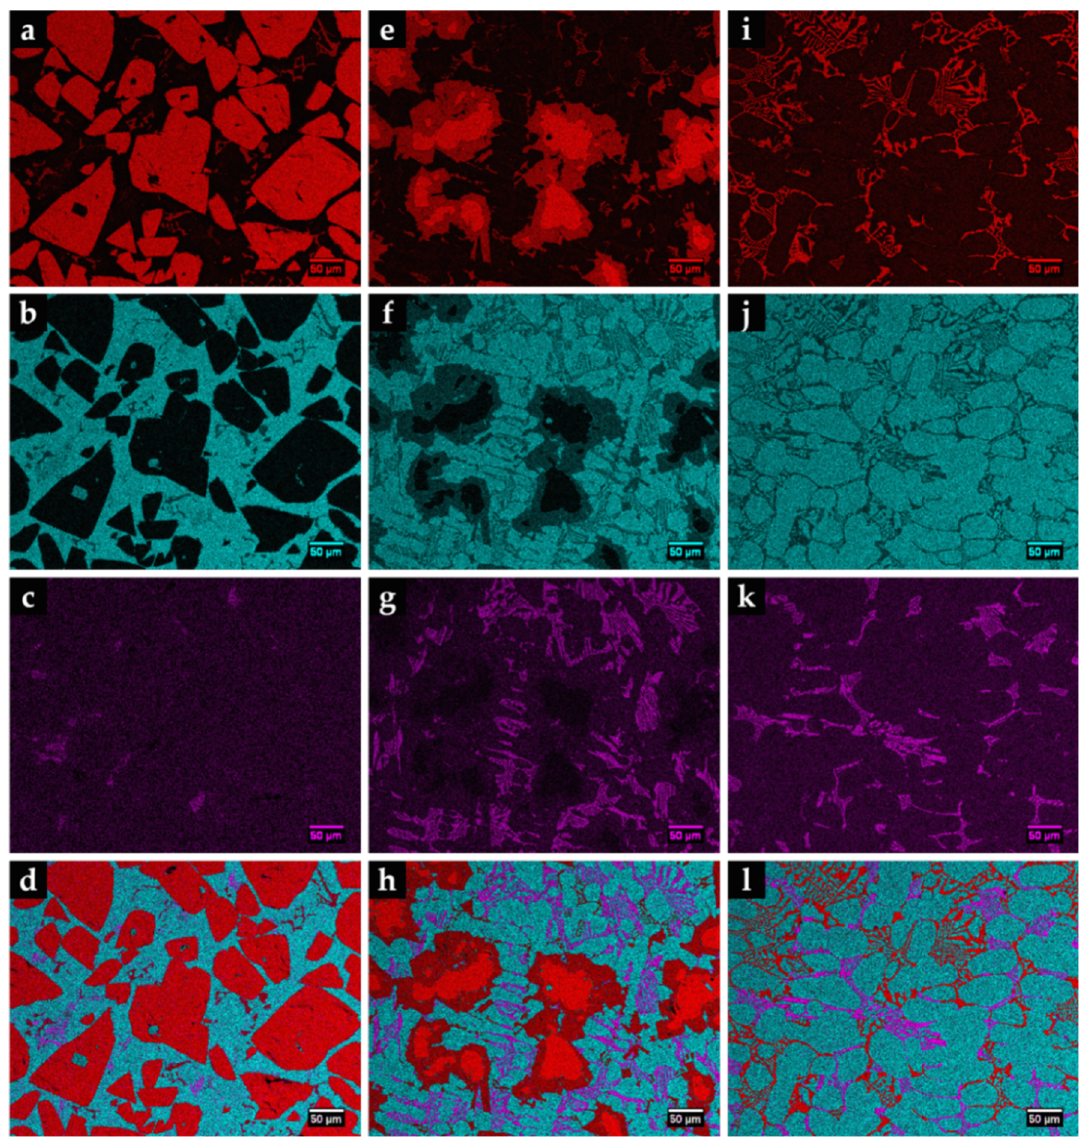
Figure 14. EDS elemental mapping of Fe (blue), Cr (pink), and W (red) for the microstructure of the three composite zones: CZ1 ( a – d ), CZ2 ( e – h ), and CZ3 ( i – l ).